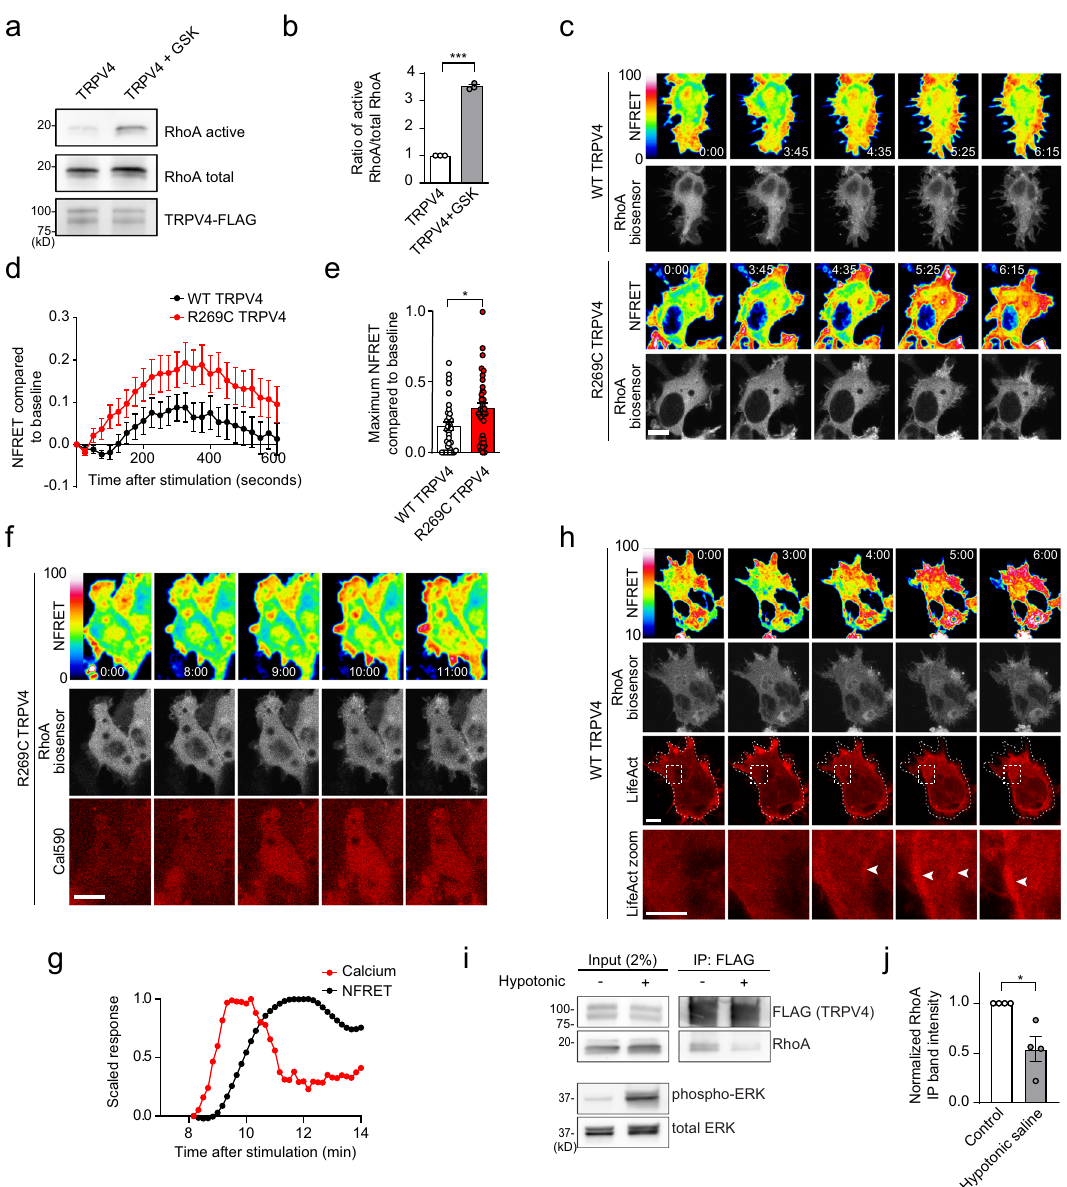
Fig. 5 TRPV4-mediated calcium in fl ux activates RhoA and cytoskeletal changes. a RhoA activation assay of T-Rex-TRPV4 cells induced with tetracycline (15 ng/ml, 16 h) in the presence of HC067, followed by removal of HC067 and treatment with GSK101 (5 min). b Densitometry of band intensities (active RhoA/total RhoA) normalized to untreated condition; representative blot shown in a . Paired two-tailed t -test, n = 3, *** p = 0.0007. c T-Rex-TRPV4 cells were transfected with RhoA2G biosensor and induced with tetracycline (15 ng/ml, 16 h) in the presence of HC067. Upon HC067 removal, cells were treated with GSK101 and RhoA FRET was assessed for 10 min. Confocal images show normalized FRET (FRET signal/FRET donor intensity) (top) and RhoA biosensor distribution (mVenus, bottom). Scale bars, 10 µ m. d , e Averaged NFRET time course ( d ) and average peak NFRET ( e ) compared to baseline of GSK101-stimulated RhoA NFRET in cells expressing WT TRPV4 or neuropathy mutant TRPV4; representative images in c . Unpaired two-tailed t -test, n = 34 cells, * p = 0.0189. f , g Time series of a R269C TRPV4-FLAG-expressing cell showing changes in calcium (Cal590) and NFRET following treatment with GSK101 at time 0 ( f ); intracellular calcium and NFRET signals shown over time ( g ). Scale bar, 10 µ m. h Time series of a WT TRPV4-FLAG-expressing cell co-transfected with LifeAct-mCherry and treated with GSK101 at time 0 showing actin stress fi ber formation (arrowheads) and cellular contraction. Scale bars, 10 and 5 µ m for inset. i T-Rex-TRPV4 WT cells were induced in the presence of HC067 as in a followed by treatment with control media or hypotonic saline (5 min) followed by TRPV4 immunoprecipitation. Hypotonic saline causes partial disruption of TRPV4 – RhoA interaction. Increased phospho-ERK (Thr202/Tyr204) indicates TRPV4-mediated calcium in fl ux. j Densitometry of band intensities (immunoprecipitated RhoA/RhoA input); representative blot in i . Paired two-tailed t -test, n = 4, * p = 0.035. Data are presented as means ± SEM. Where indicated, HC067 was used at 0.5 µ M; GSK101 at 100